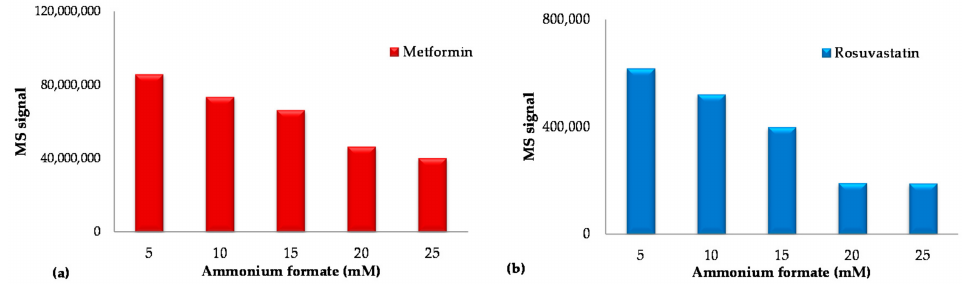
Figure 3. Impact of the concentration of ammonium formate in the mobile phase on the MS signal of ( a ) metformin and ( b ) rosuvastatin. Data have been obtained from the analysis of human plasma samples spiked with 2500 ng mL − 1 metformin, 50 ng mL − 1 rosuvastatin and 190 ng mL − 1 N-despropyl ropinioro